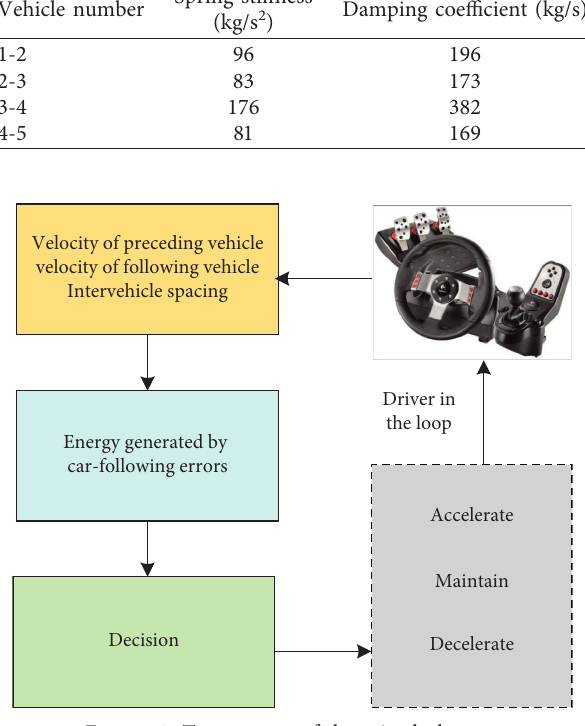
Figure 9: Test process of the mixed